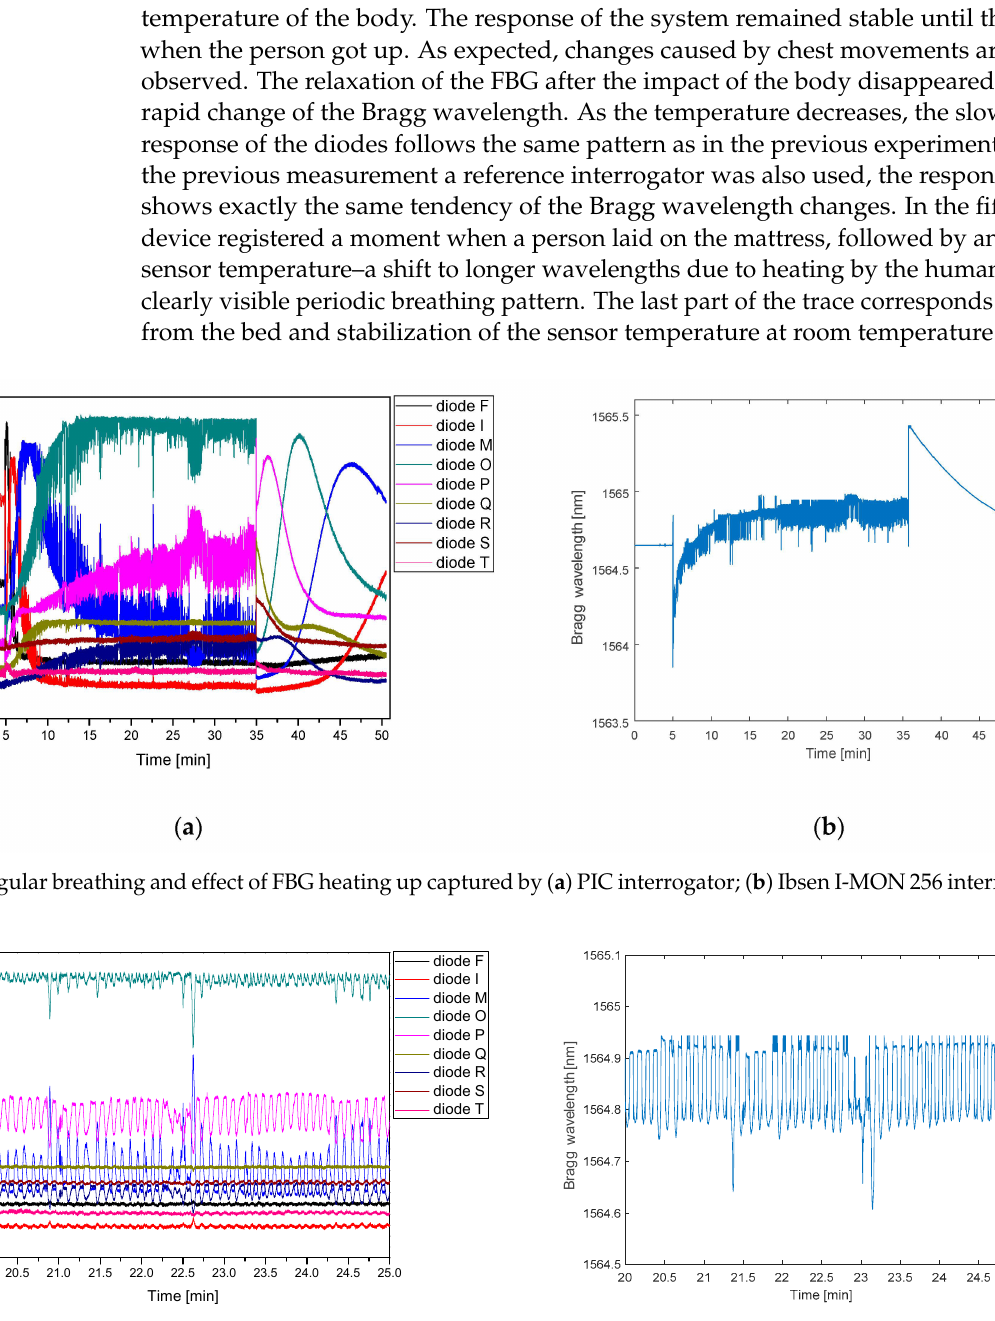
( b ) Figure 14. Result of measurement with person lying on the mattress and changing breathing pace: regular breathing (R), apnea (A), fast breathing (F) and regular breathing (R), captured by ( a ) PIC interrogator; ( b ) Ibsen I-MON 256 interrogator. Effect of FBG heating up is visible also. The corresponding patterns may be clearly distinguished with respect to the charac- teristics recorded using both devices. In addition to the breathing pattern, the graph shows the global effect of the FBG heating from the human body, manifested by an in- crease of the Bragg wavelength. This effect is noticeable even in a relatively short section of the apnea. The disturbance recorded by both devices in ~62 s of the measurement was the result of the patient’s movement. Due to a slight change in body position, the tension on the FBG changed, which is also visible in the graph. It should be noted that any physical